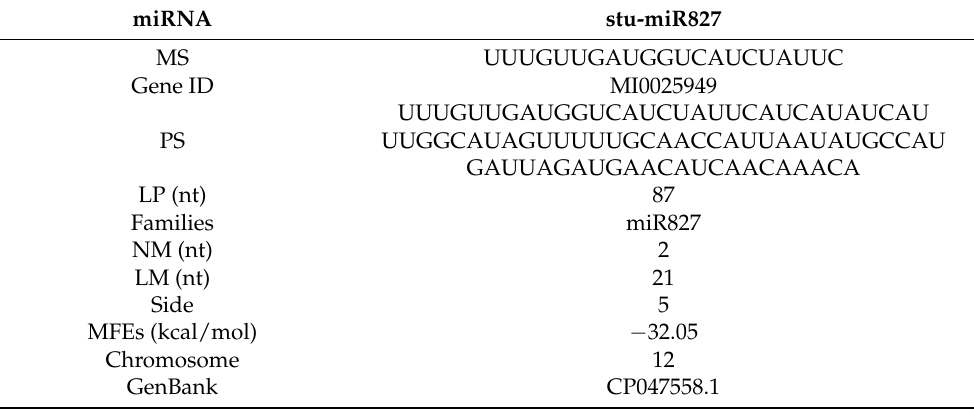
Figure 1. Characterization and qRT-qPCR analyses of stu-miR827-5p expression profiles in different tissues and response to drought stress in potato. ( A ) Hairpin secondary structures of stu-miR827 precursor as predicted by MFold, and the mature stu-miR827-5p sequence is highlighted in red. ( B ) Relative expression levels of the stu-miR827-5p in different tissues of potato. ( C ) Relative expression levels of the stu-miR827-5p under drought stress. Q9 represents the potato variety “Qingshu9” and DXY represents the potato variety “Atlantic”. Table 1. The detailed information of